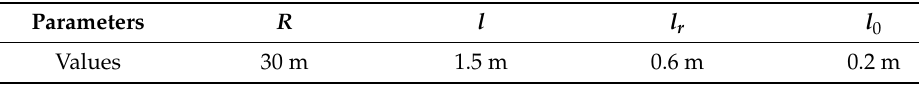
Figure 7. Preset Routes. Table 1. Parameters of Tractor and Seeder.